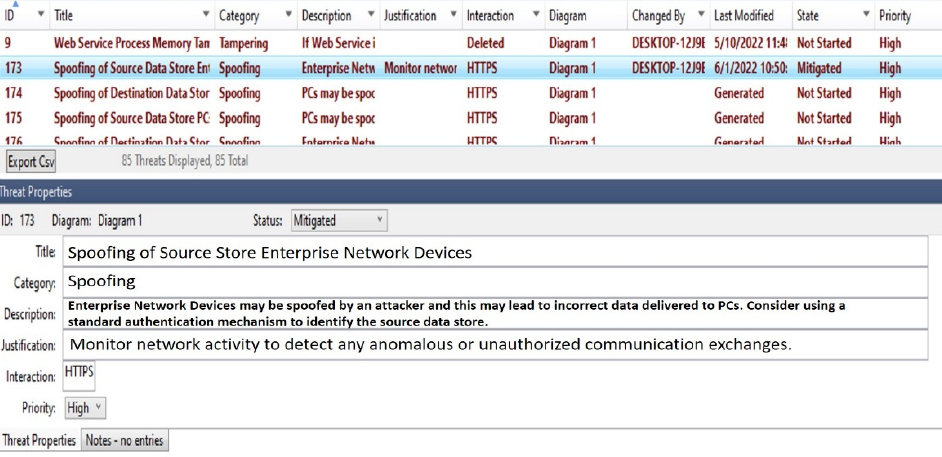
Figure 9. Reduced